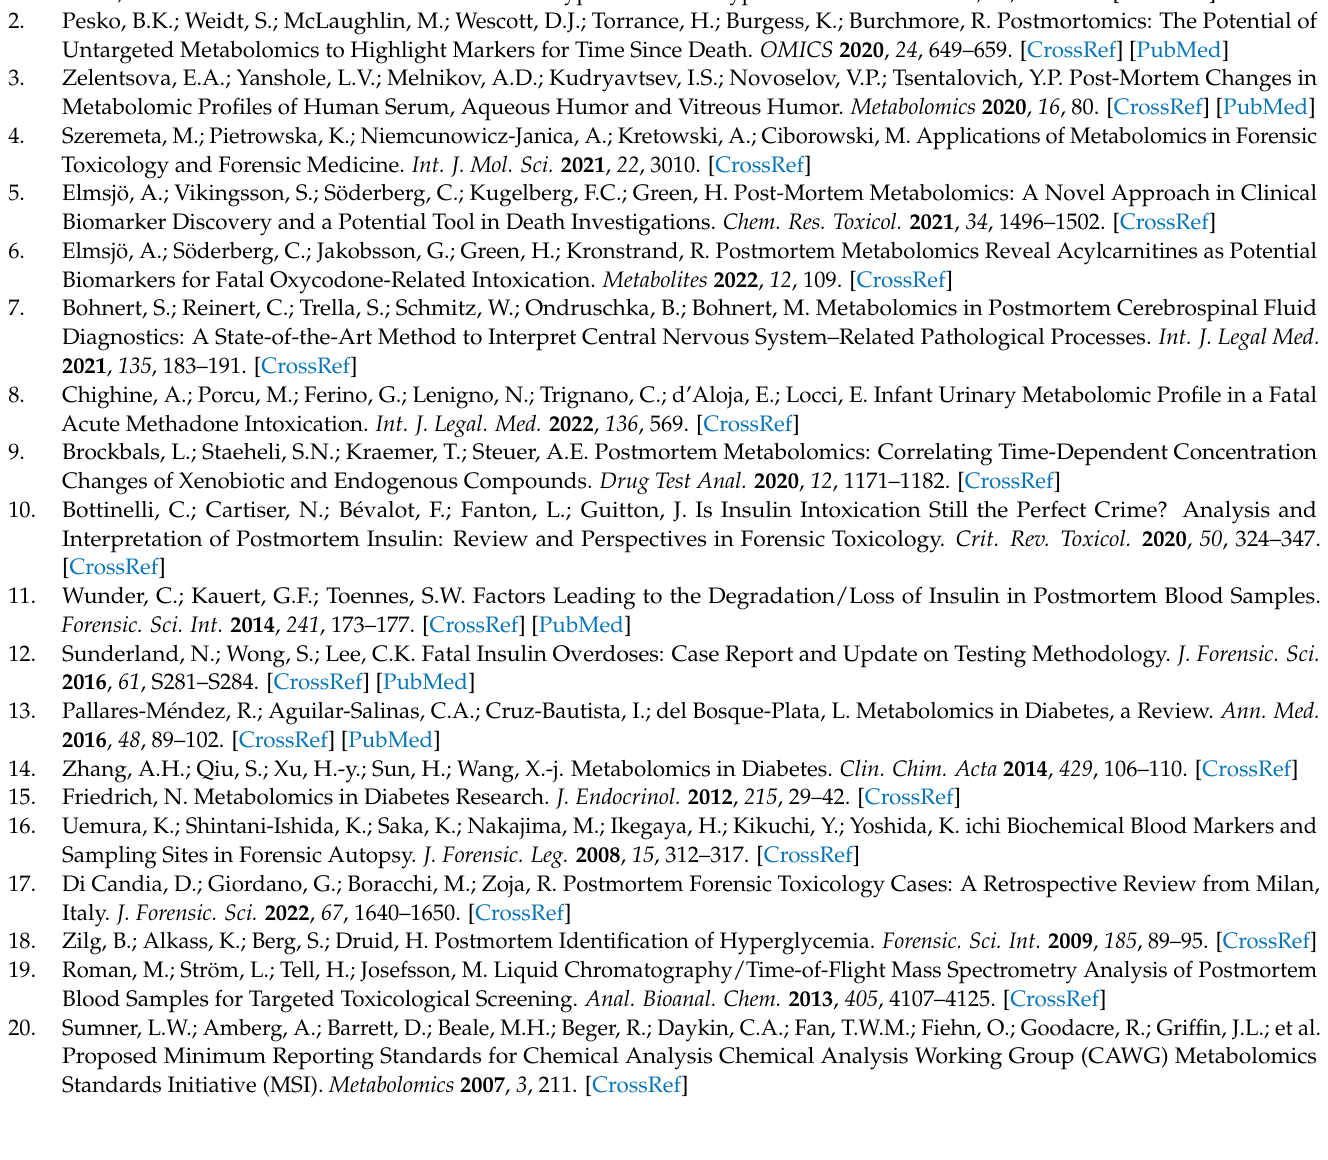
circles) and hypo (red triangles) group. (B) OPLS-DA score plot comparing hyper (blue squares) and hypo (red triangles)